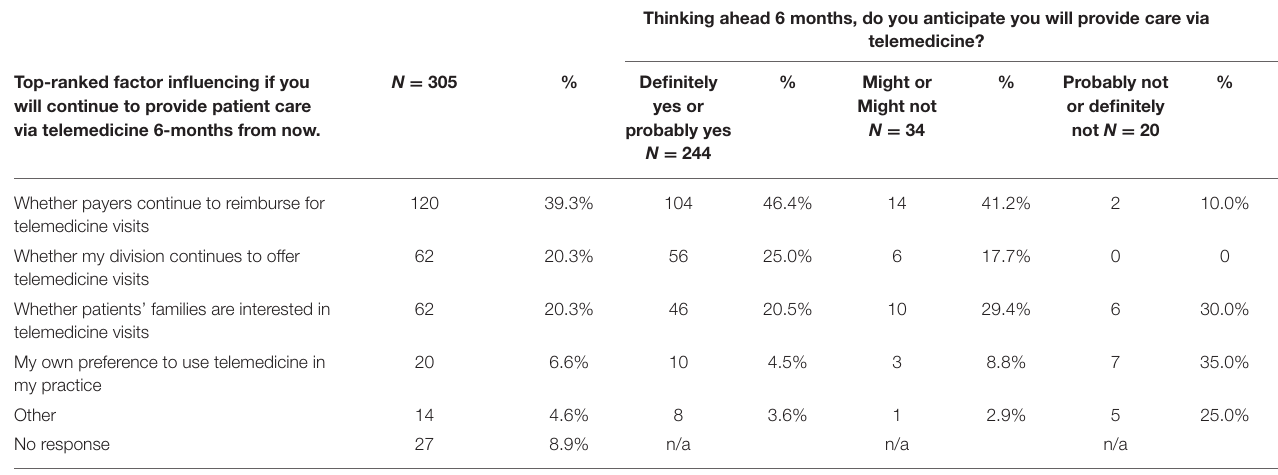
TABLE 4 | Top-ranked factors influencing provider intention to continue practicing telemedicine in 6